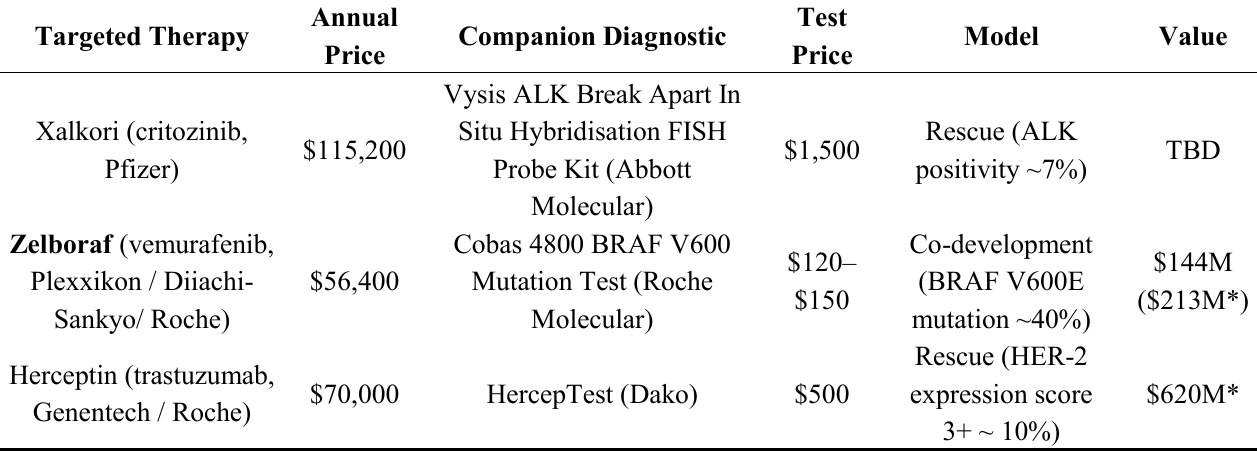
Table 1. The Price vs. Value Imbalance. * Projected Annual Sales 2012 based on HY12 – roche.com. Targeted